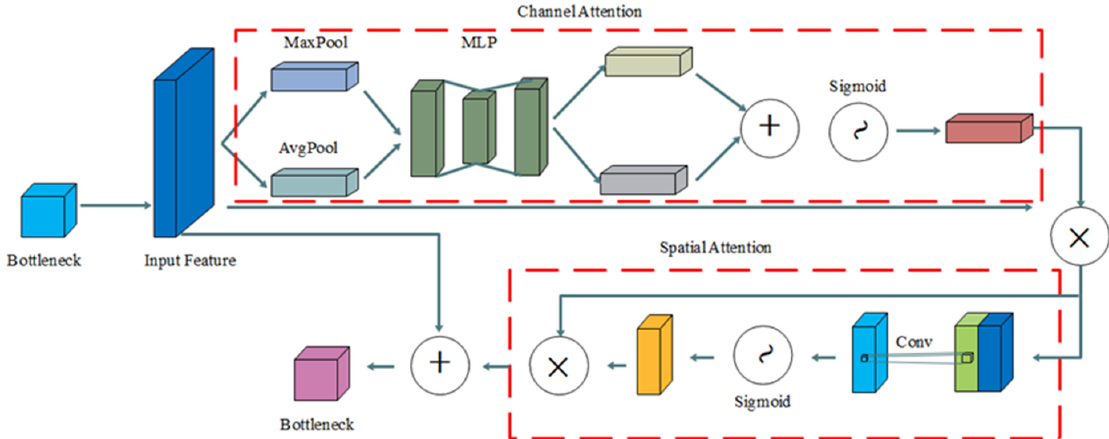
Figure 7. CBAM structure. Where: Conv represents convolution layer. MLP represents multilayer perceptron. 𝐴𝑣𝑔𝑃𝑜𝑜𝑙 represents the average pooling operation of the feature map. 𝑀𝑎𝑥𝑃𝑜𝑜𝑙 represents the maximum pooling operation of the feature map.